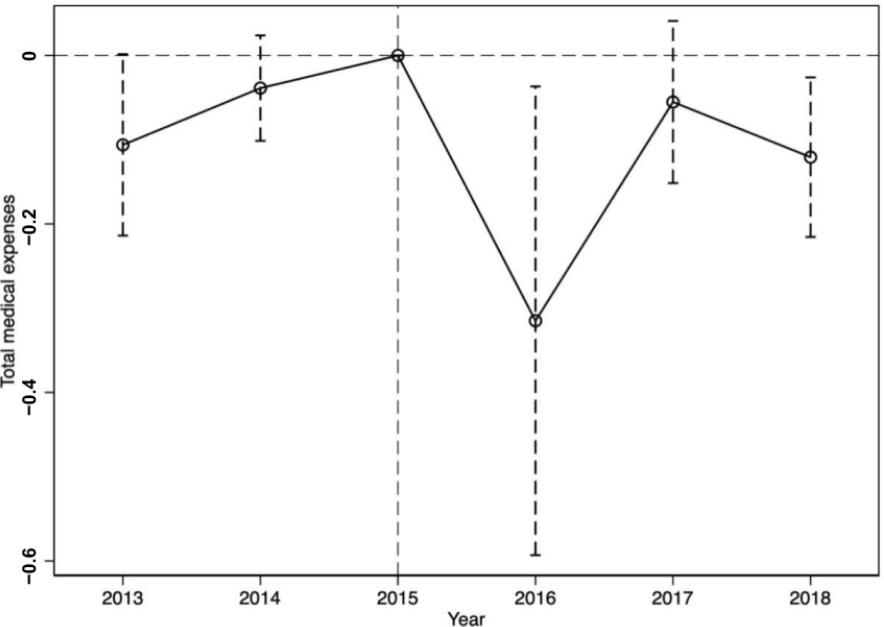
Figure 2. Event-study analysis of the effect on total medical expenses borne by the UURBMI and UEBMI. The figure plots the coefficients and their associated 95% confidence interval based on Equation (2). Vertical bands represent 95% confidence intervals, adjusted for county-level cluster- ing.